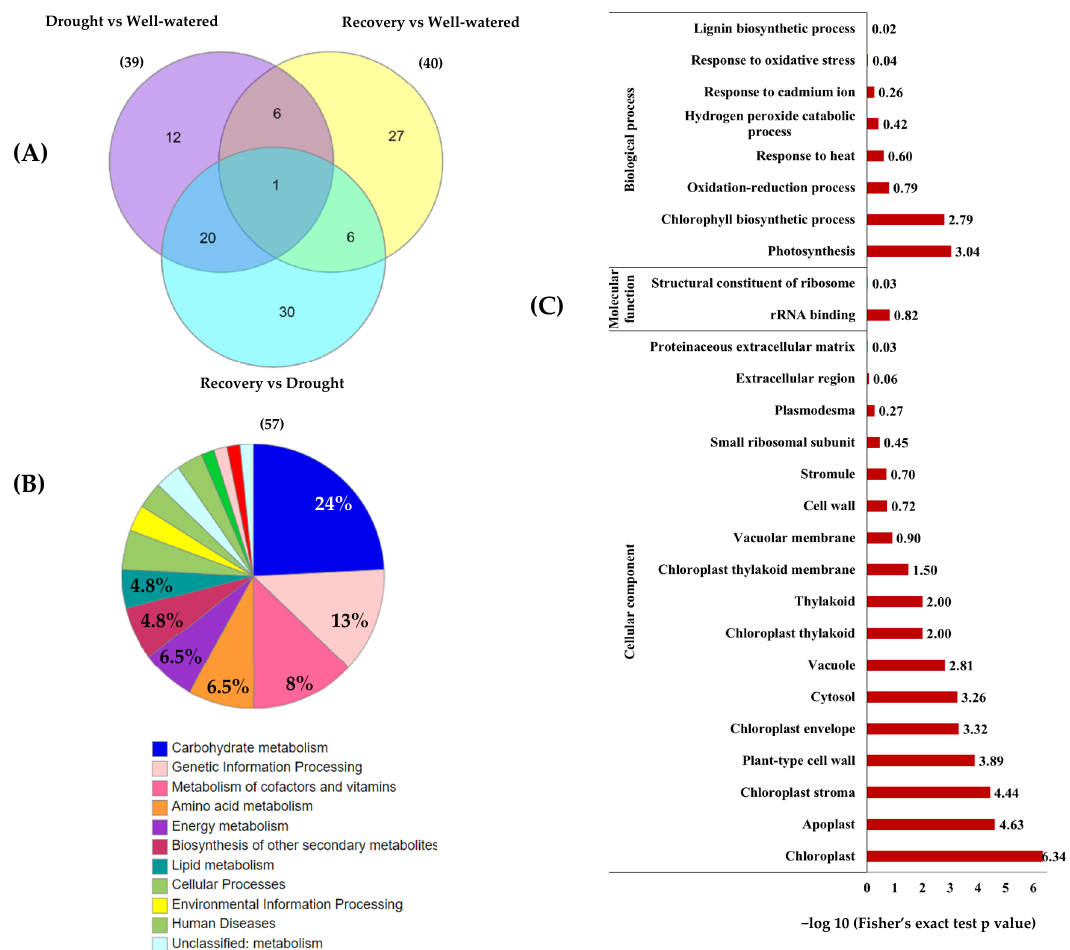
Figure 8. Functional categorization and enrichment of differentially changed proteins between well-watered, drought, and recovery samples. ( A ) The Venn diagram represents the comparison of differentially abundant proteins identified in the leaves of Pandanus plants treated with drought stress, well-watered, and recovery; ( B ) KEGG enrichment of differentially changed proteins based on functional category; and ( C ) gene ontology enrichment based on KEGG pathway according to biological processes, molecular functions, and cellular components.